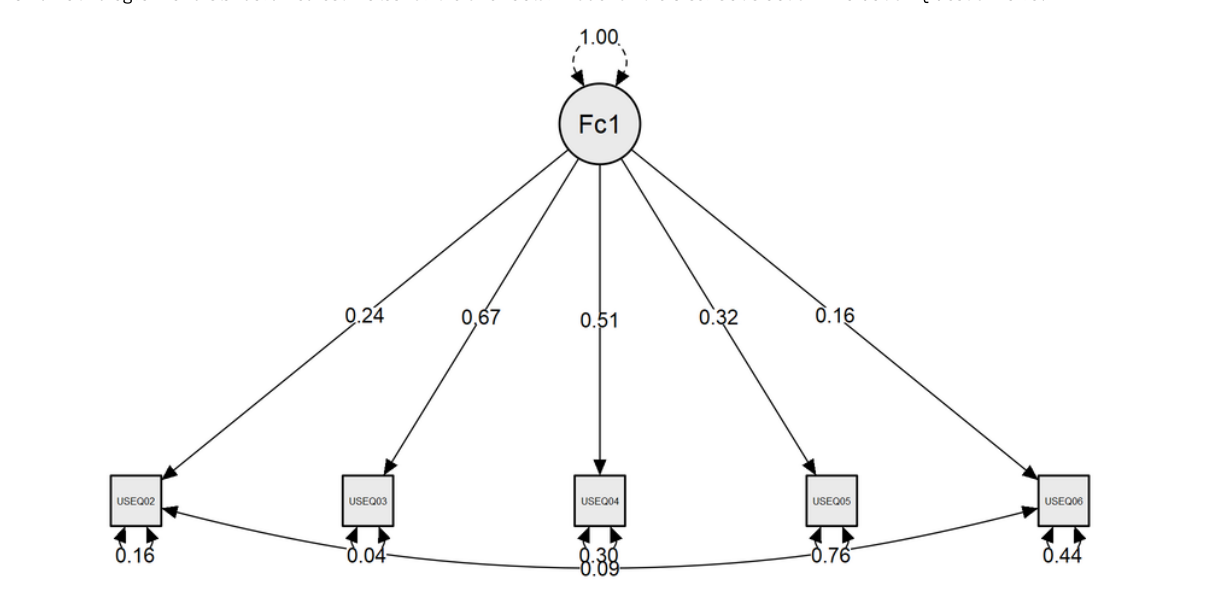
Figure 1. Path diagram and standardized estimates for the one-factor model of the User Satisfaction Evaluation